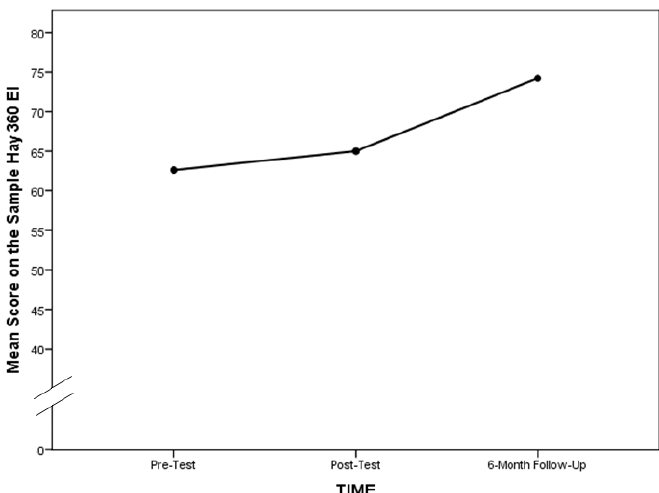
Figure 2. Line graph of the emergency medicine resident intervention group’s mean emotional intelligence scores over three time periods: pre-test, post-test, and six-month follow up. EI, emotional